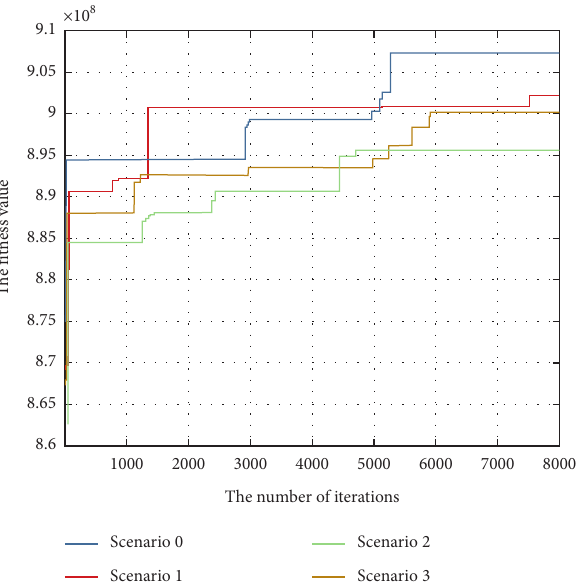
Figure 6: The convergence of LSN in NO phase ( G 3 ).